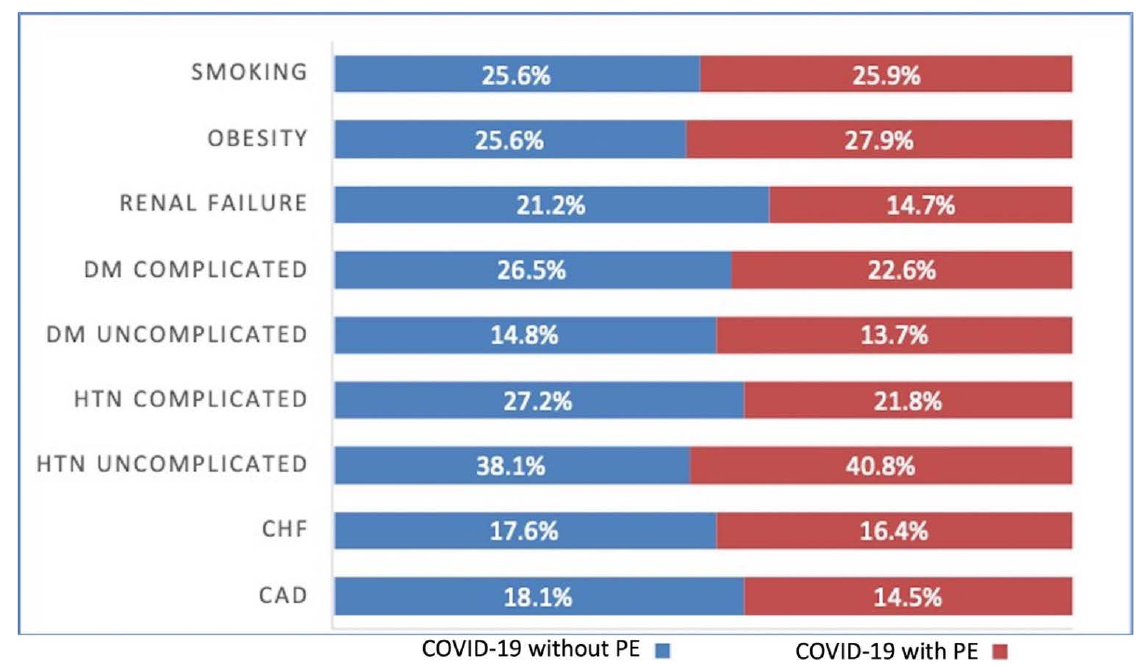
Figure 1. COVID-19 and Pulmonary embolism (PE) patient comorbidities. DM = Diabetes Mellitus, HTN = Hypertension, CHF = Congestive heart failure, CAD = Coronary artery disease, +ve = Positive, − ve = Negative.